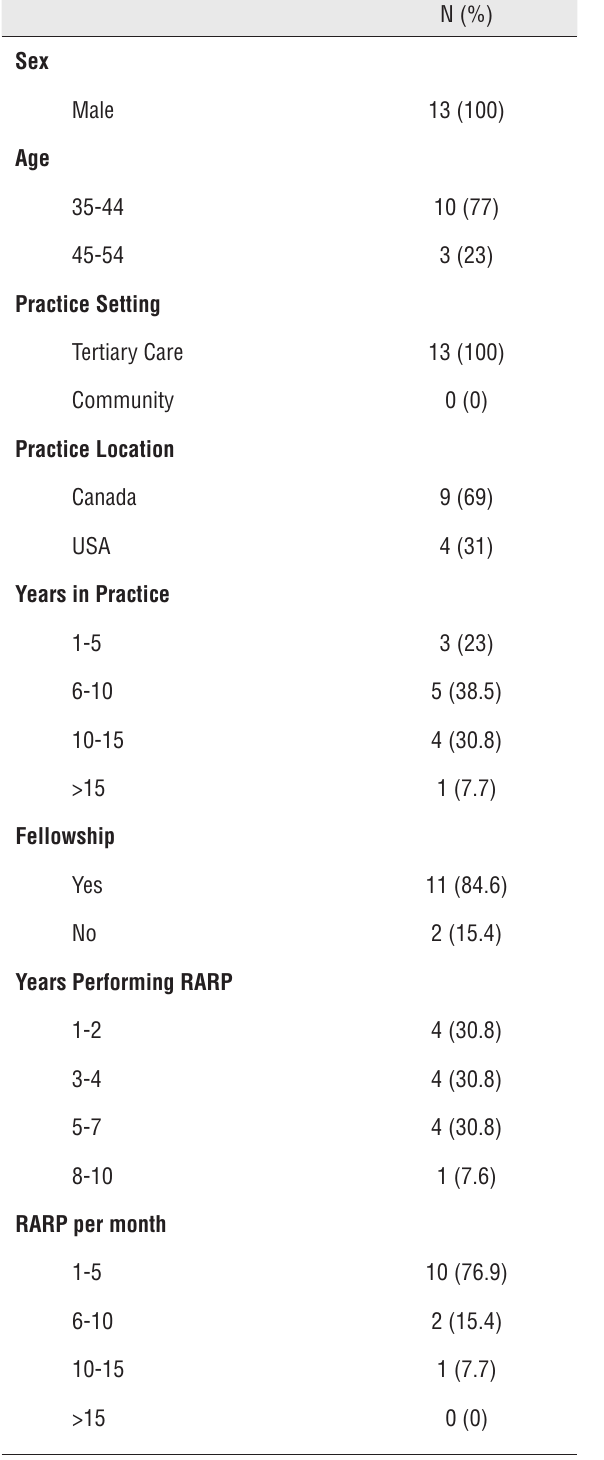
Table 1 - Demographics of External Delphi